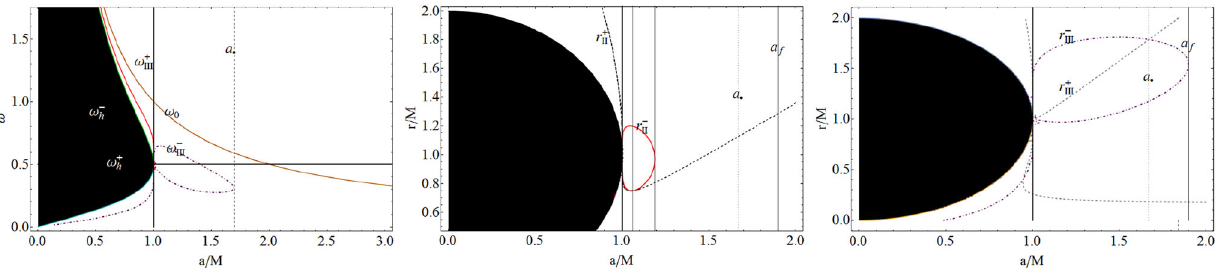
and r ± ,solutionsof ∂ 2 r ω ± = and ω ± , solutions of ∂ 2 ω r ± s = 0 and ∂ 3 r r ± s = 0, respectively, are II III III shown as functions of the spin a / M . Regions bounded by the horizons frequencies ω ± are black H II